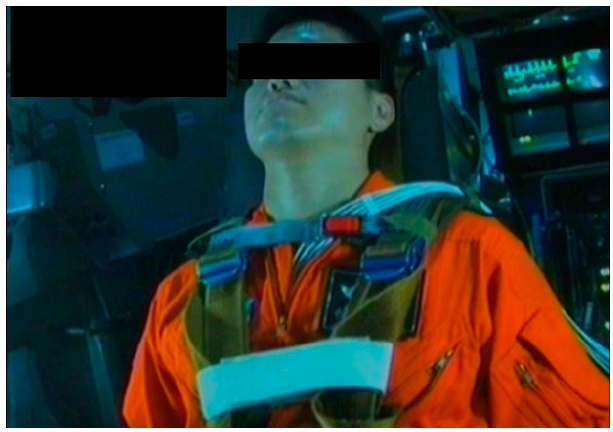
Figure 4. G tolerance test inside the gondola view.